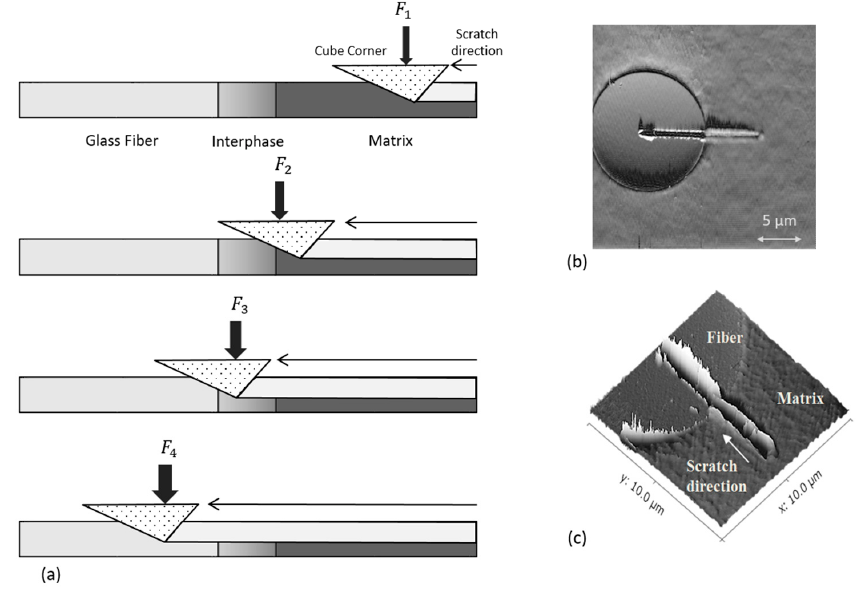
Figure 2. Nano-scratch with constant scratch depth following [35]: ( a ) representation of the scratch path at constant depth from the matrix to the fiber; ( b ) imaging of the PBT-GF20 sample after nano-scratching; ( c ) 3D-imaging of ( b ).